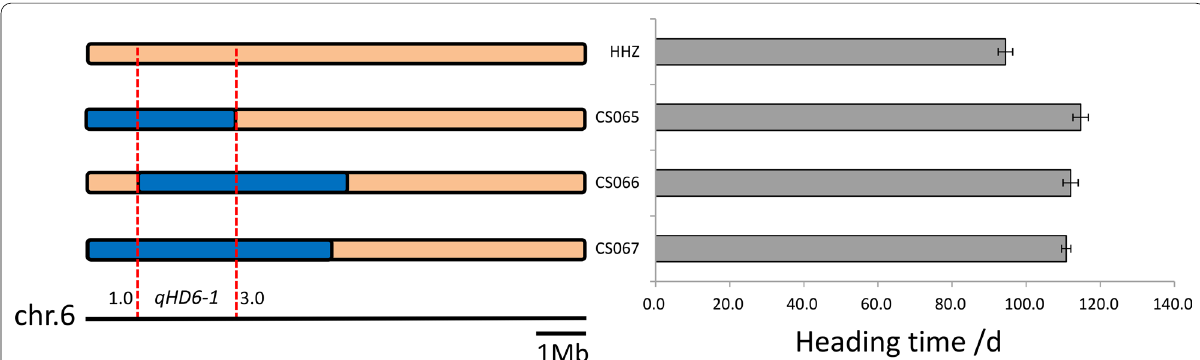
a The percentage of phenotypic variation explained (PVE) by the detected QTL; b Additive effects (Add), the positive value suggests that alleles from BAS increase the effect